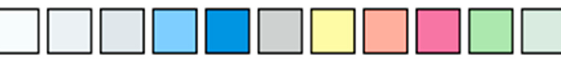
Figure 11. The HERE Maps color scheme.